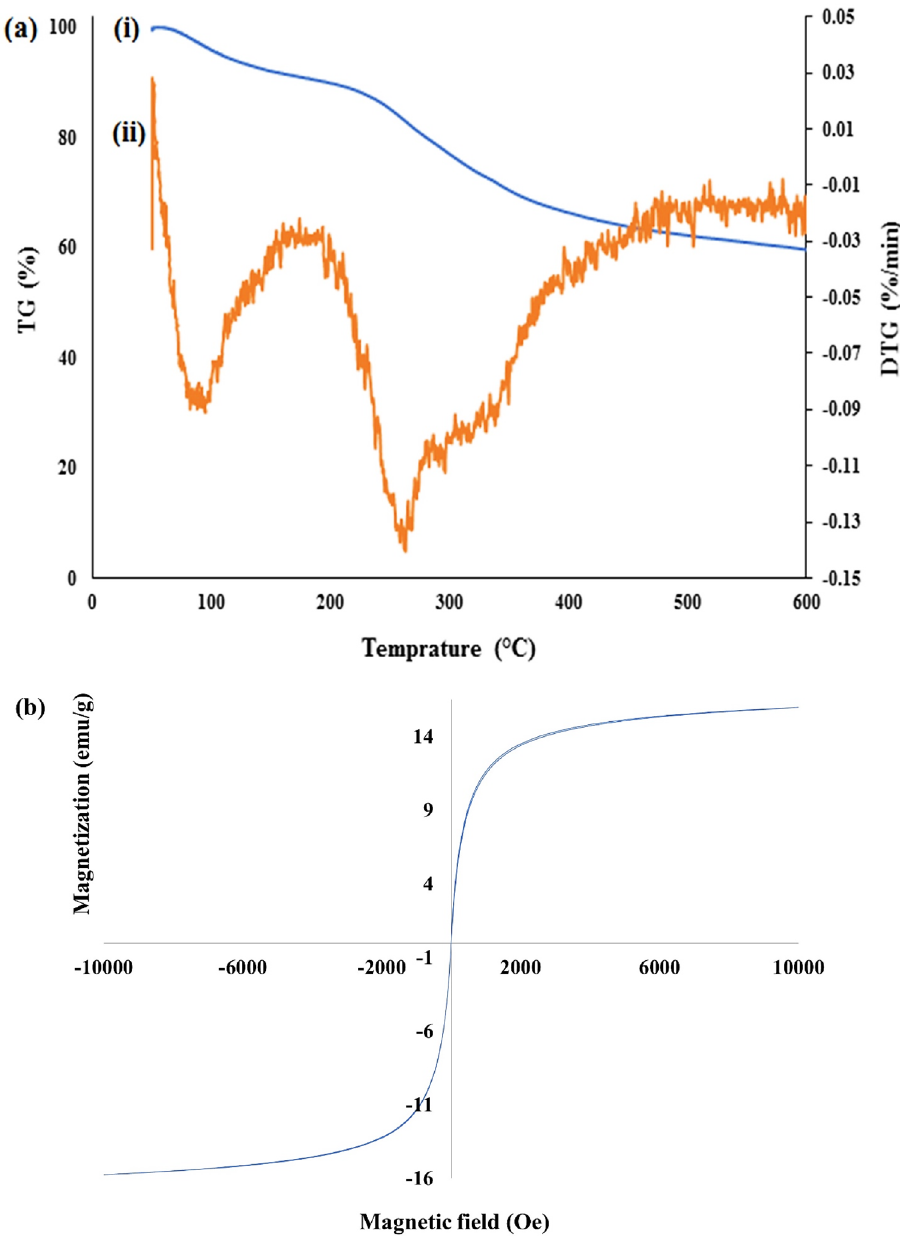
Figure 3. ( a ) The thermogravimetric analysis (i) and DTG curve (ii) of SA/SF/HNTs/Fe 3 O 4 biocomposite, and ( b ) the vibrating-sample magnetometer of SA/SF/HNTs/Fe 3 O 4